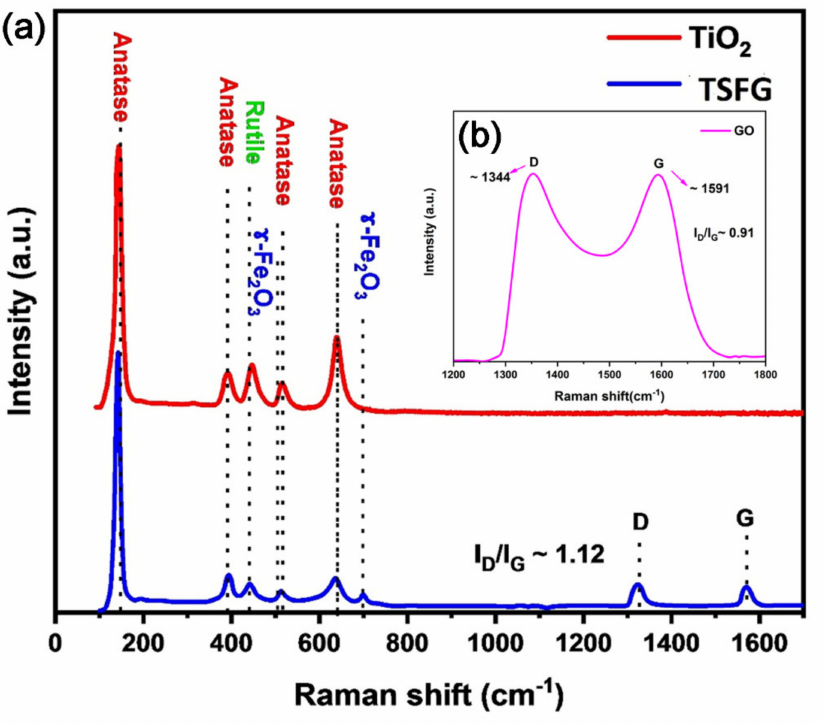
Figure 4. Raman spectra of ( a ) TiO 2 and TSFG; ( b ) GO samples in the wave number range from 100 to 1800 cm − 1